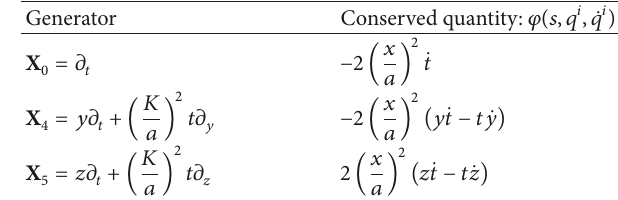
Table 30: Conserved quantities corresponding to each Noether symmetry.